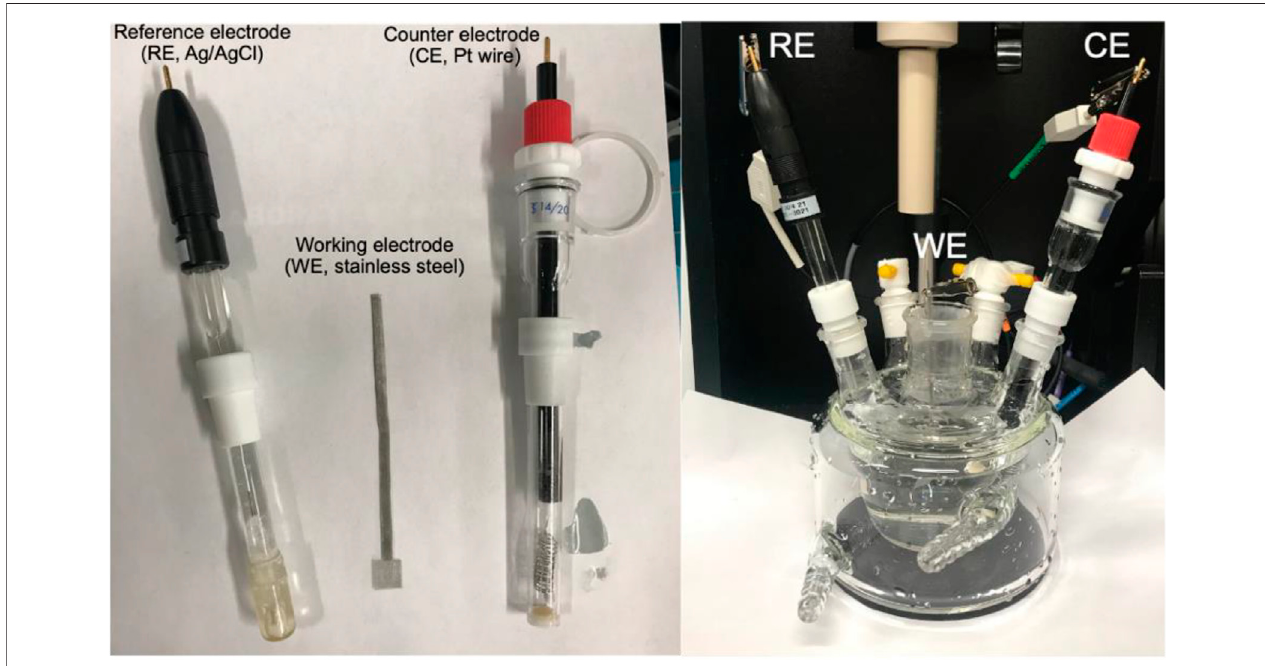
FIGURE 1 | Picture of WE, CE, and RE, and the corresponding connections in a cell.